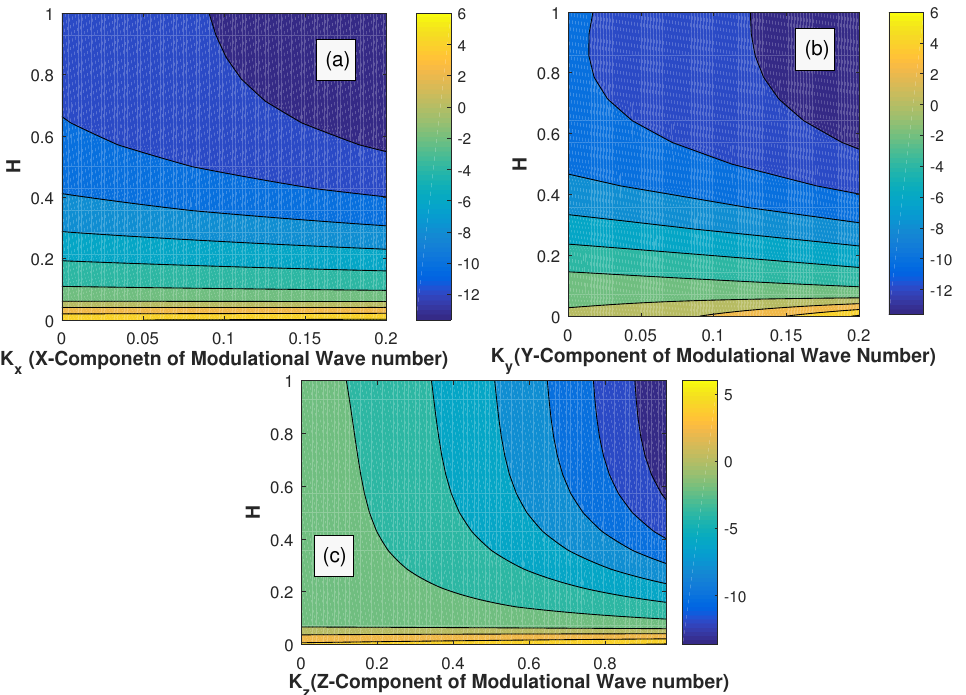
Figure 10. Contour plot of the α / Q . The variation is shown with respect to the quantum diffraction parameter H and modulational wave number ( K x , K y and K z